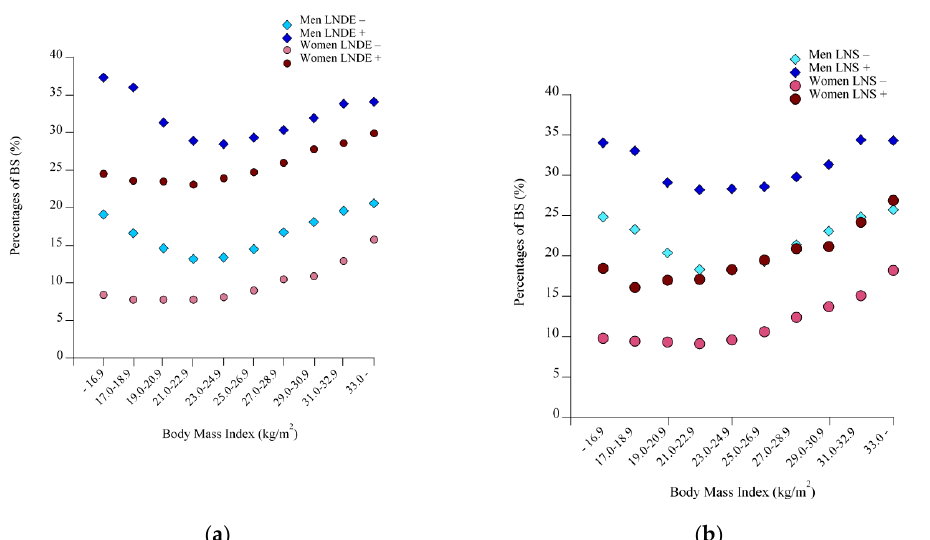
Figure 2. Percentages of breakfast skipping (BS) according to BMI categories, sex, and LND or LNS. ( a ) Men with or without LND, and women with or without LND. ( b ) Men with or without LNS, and women with or without LNS. Each symbol indicates the percentage for that group. BS: Breakfast